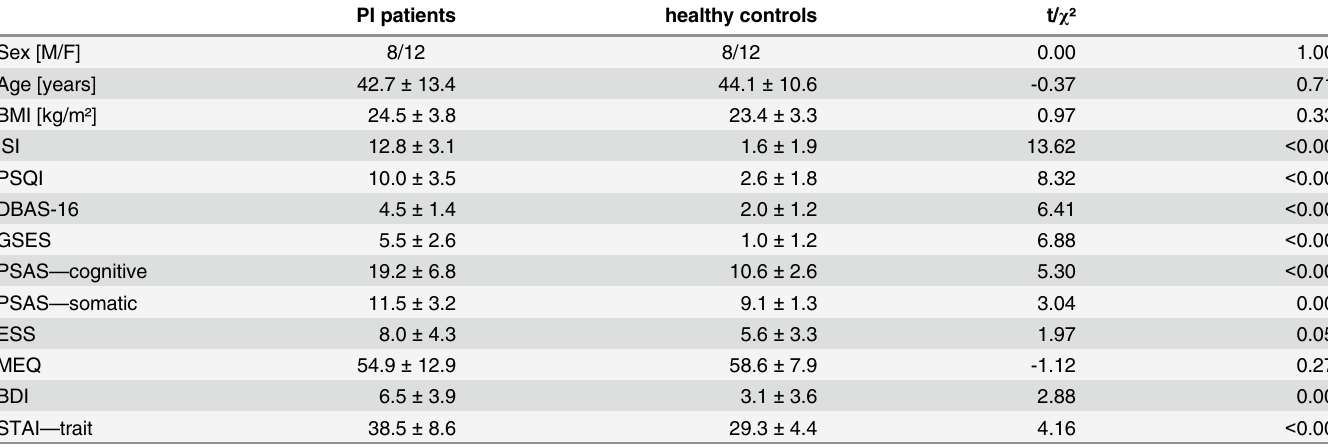
Table 1. Description of the study population (means ± standard